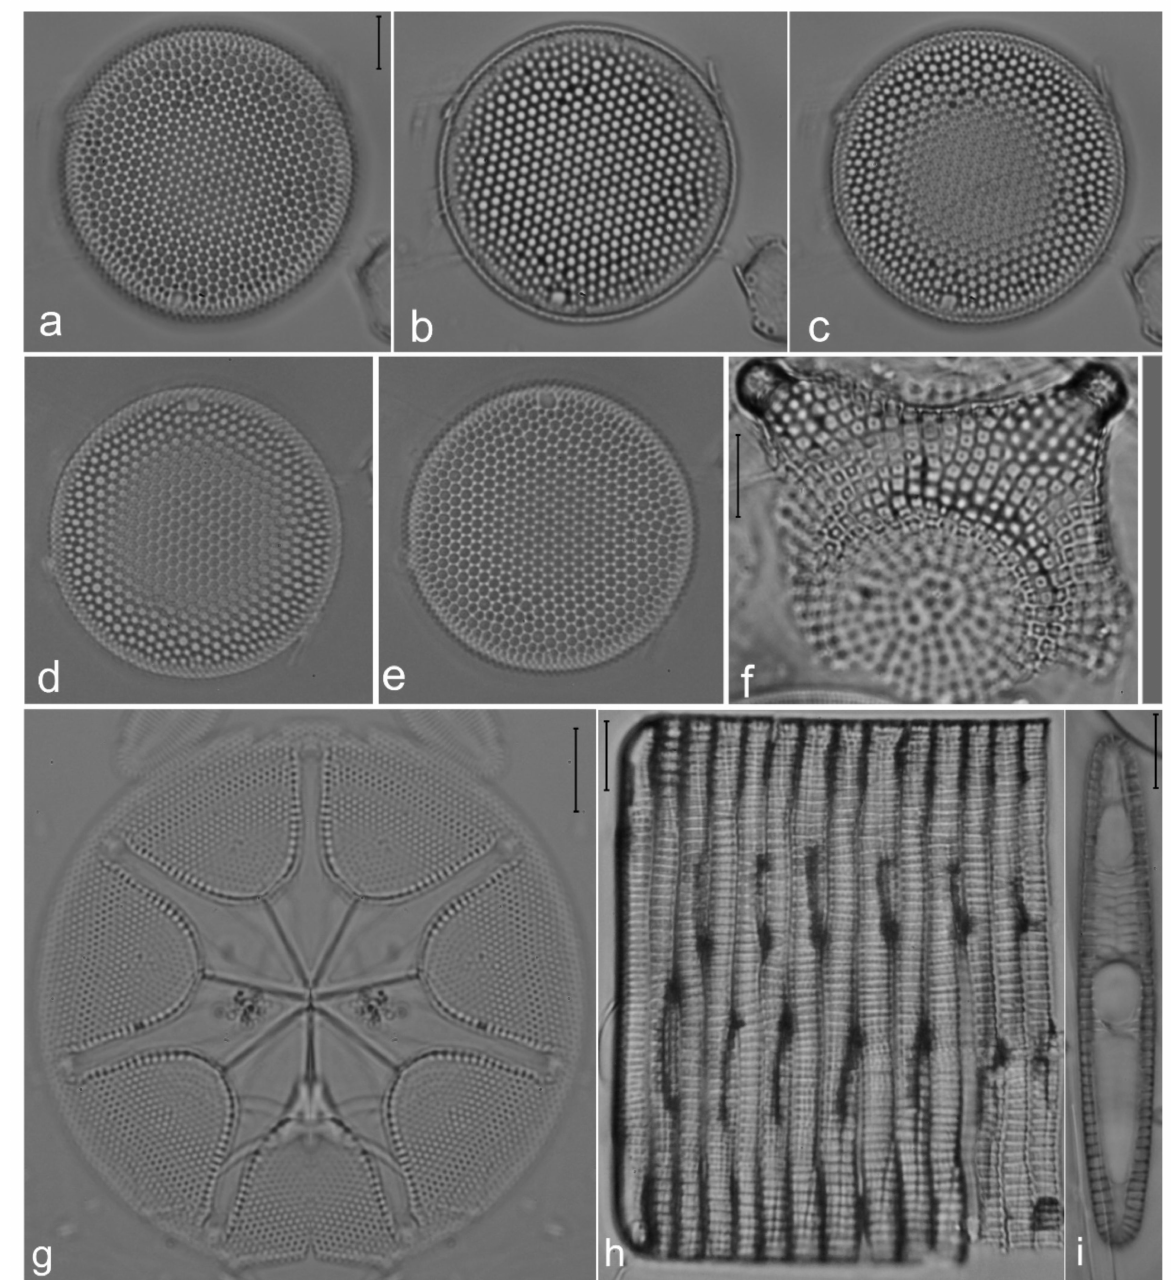
Figure 5. ( a – e ) Roperiatesselata valvesindifferentfocalviews;( f ) Triceratiumbiquadratum ;( g ) Asterolampramarylandica ; ( h , i ) Rhabdonema adriaticum image, ( h ) frustule in girdle view. ( i ) Scale bar = 10 µ